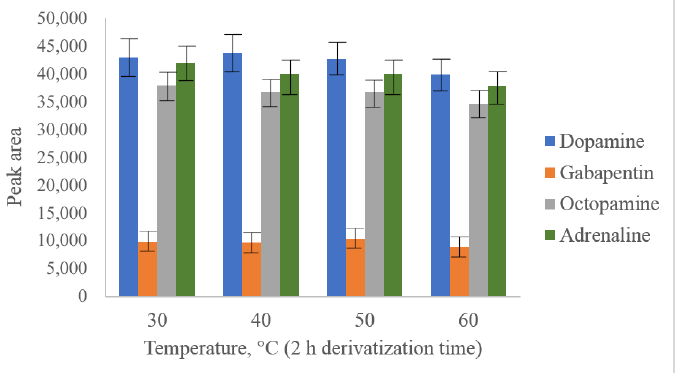
Figure 3. Optimization of derivatization temperature with PG-Cl at 100 ng/mL dopamine, octopamine, adrenaline and 50 ng/mL gabapentin.